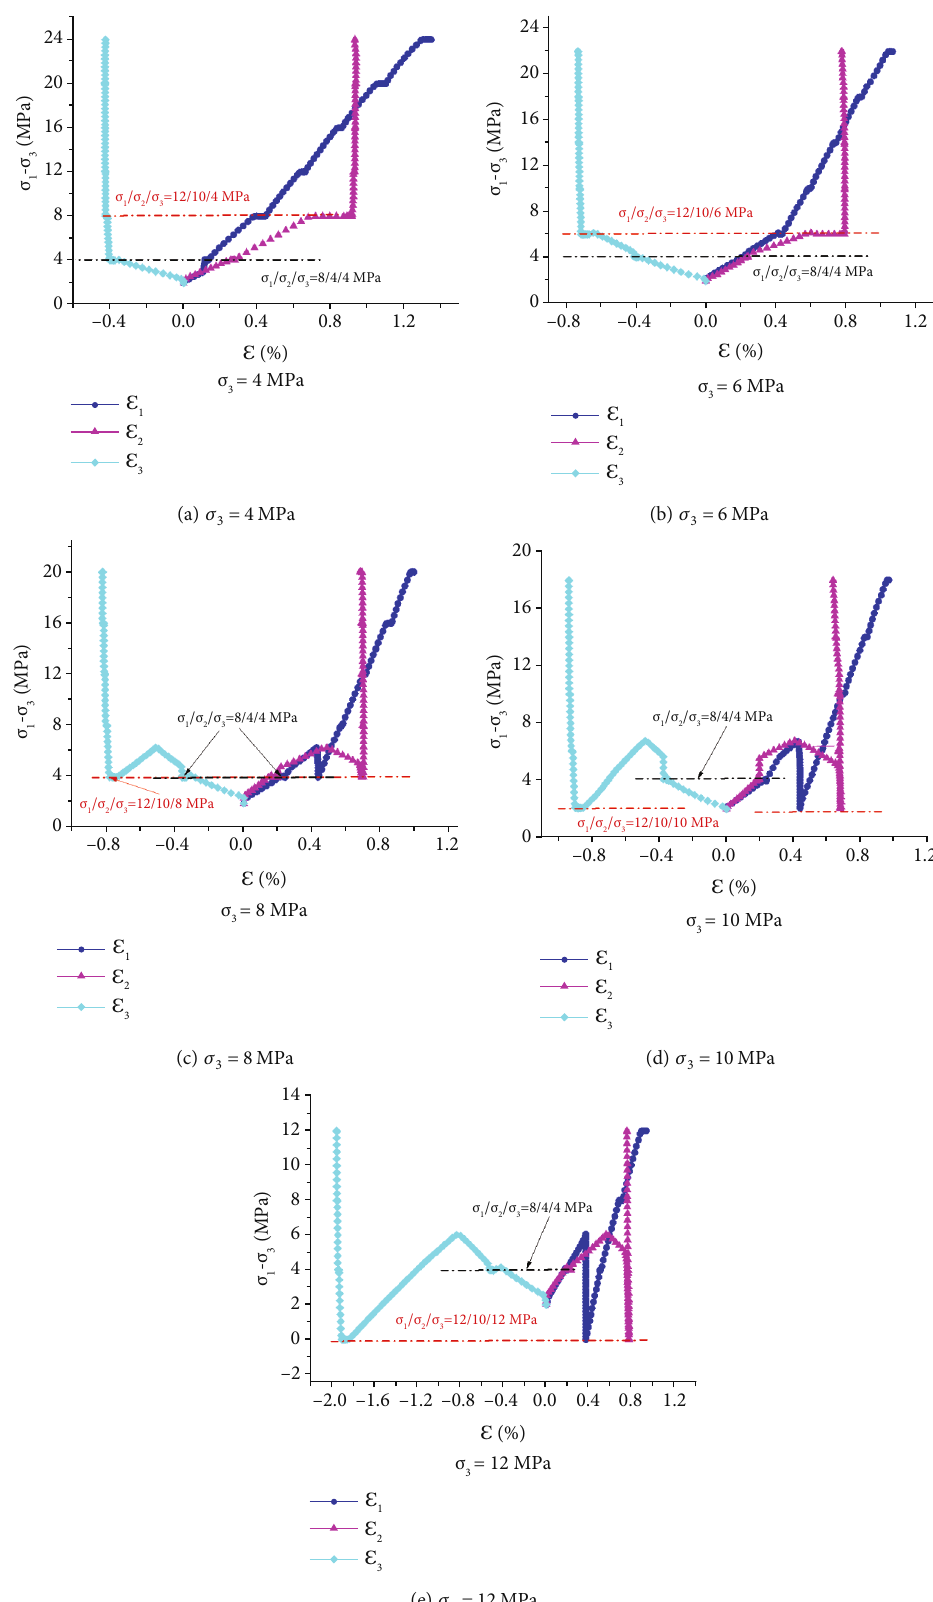
Figure 8: Deviatoric stress-strain of grouting sample under three-dimensional